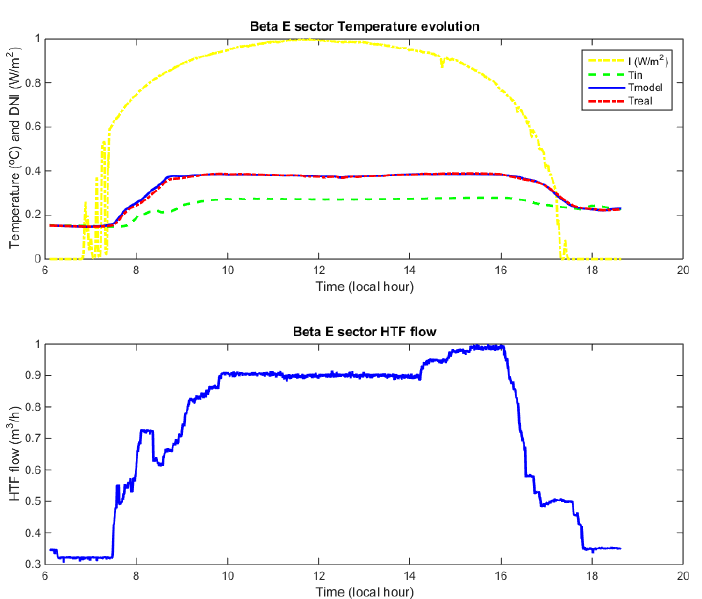
Figure 5. Beta North-East sector, model vs. real evolution: ( top ) model (blue solid) and real (red dash-dotted); and ( bottom ) HTF